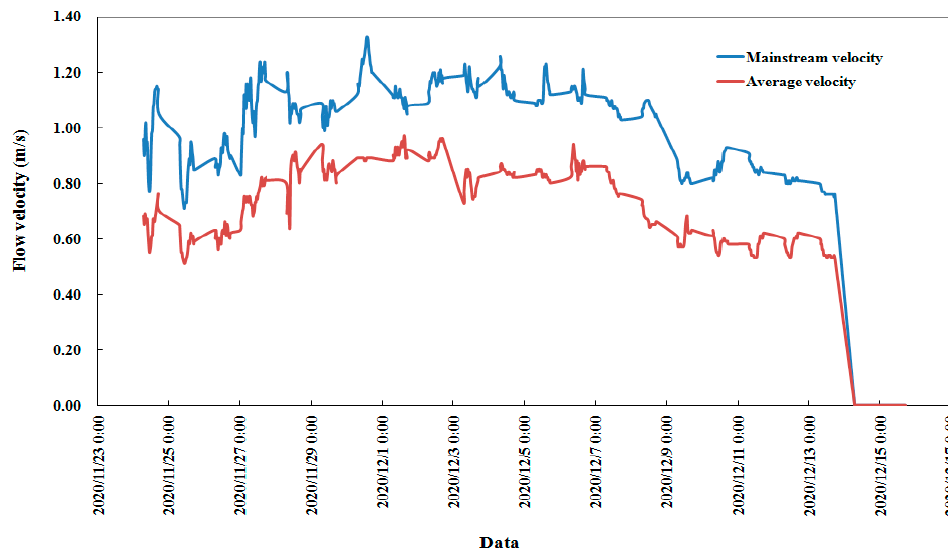
Figure 6. Flow ice velocity of the Shisifenzi reach in the 2020–2021 ice period. Flow ice scenes on different dates of the 2020–2021 ice period in the Shisifenzi reach are shown in Figure 7. The times of different dates in Figure 7 are basically the same, at approximately 10 a.m. The ice growth process of this reach during the 2020–2021 ice period can be understood by comparing the subfigures. To further quantify the flow density, combined with the image processing technology, the evolution process of flow density is 85.82%, and then the flow ice density gradually decreased, mainly due to the fact